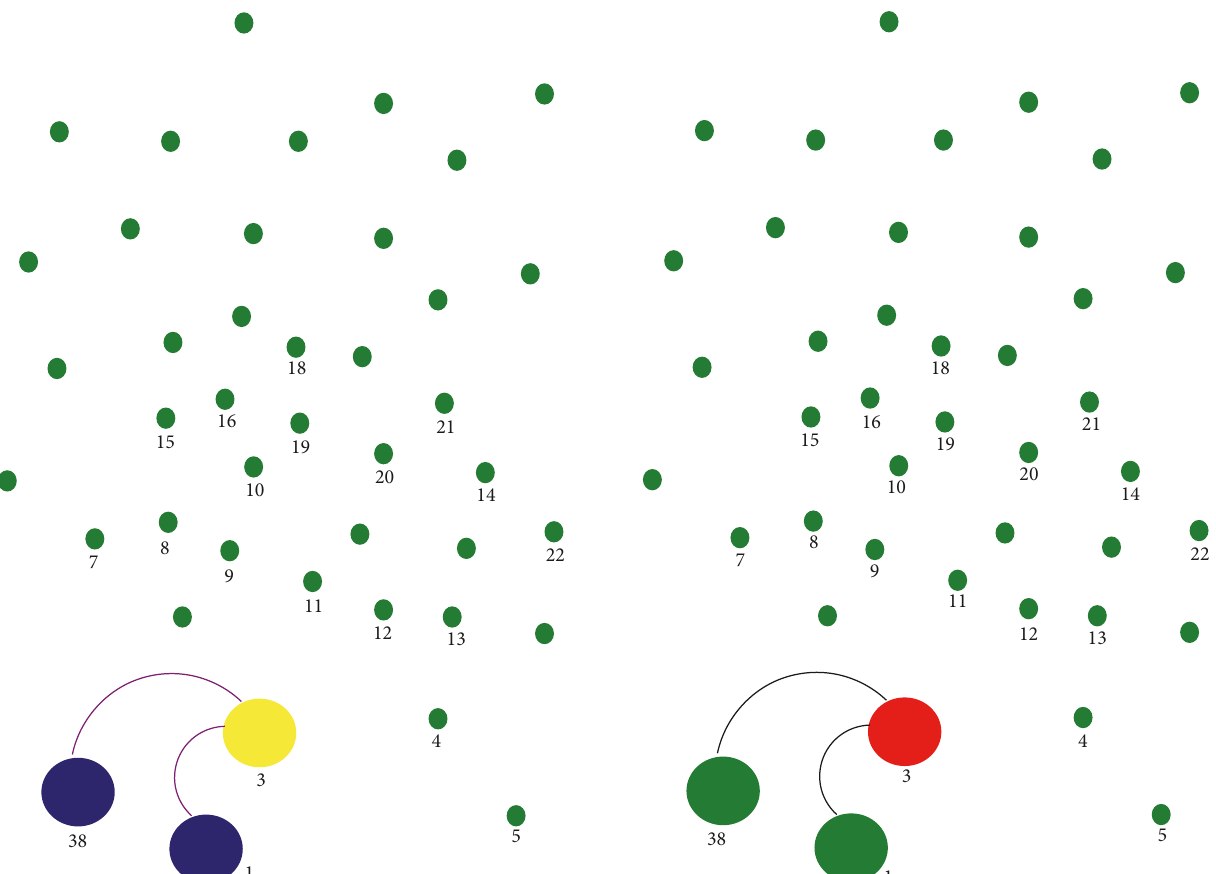
Figure 4: Nodes 1 and 38 send information and node 3 receives it.